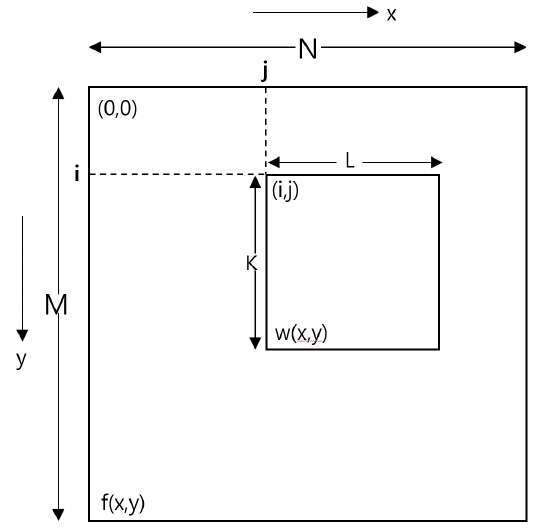
Figure 3. Conceptual diagram of cross correlation between template image and target image for calculating the pattern matching score.